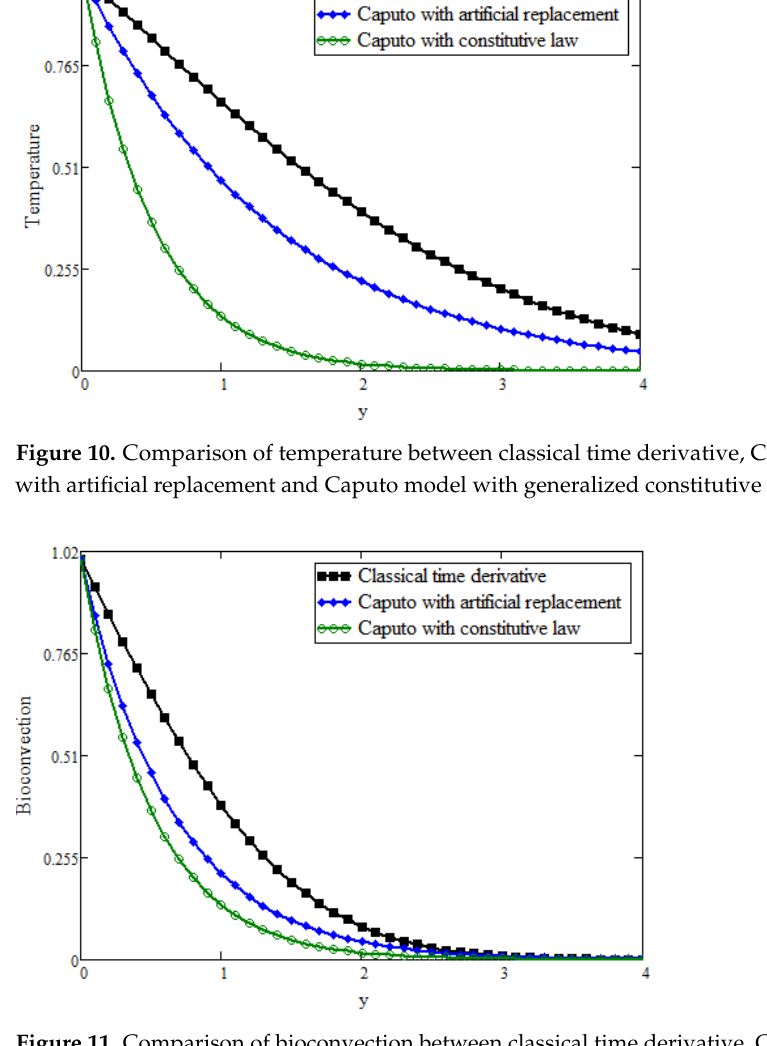
Figure 11. Comparison of bioconvection between classical time derivative, Caputo fractional model with artificial replacement and Caputo model with generalized constitutive